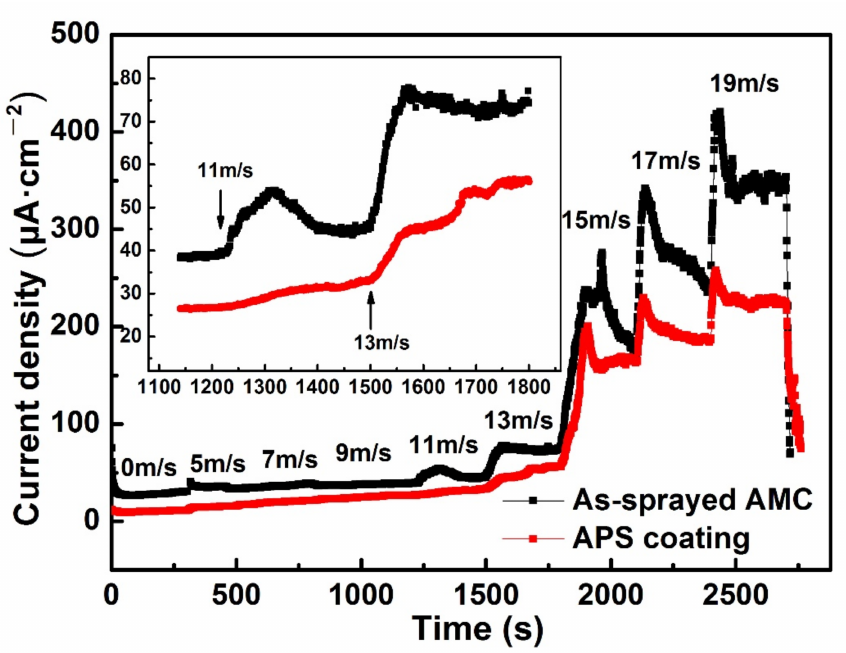
Figure 10. Records of the current density for the as-sprayed and APS coatings at 0 V SCE with increasing the flow